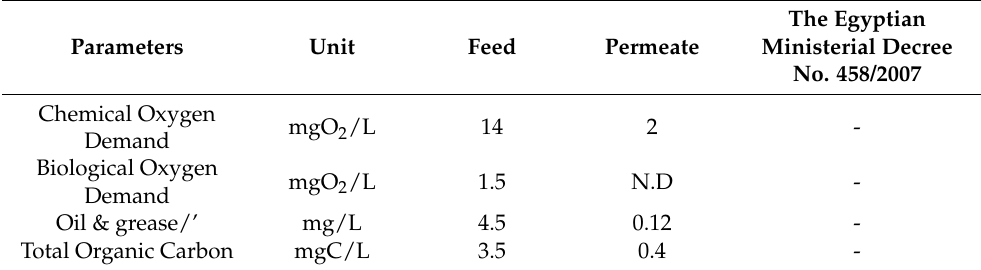
Table 10. Organic analysis for seawater and